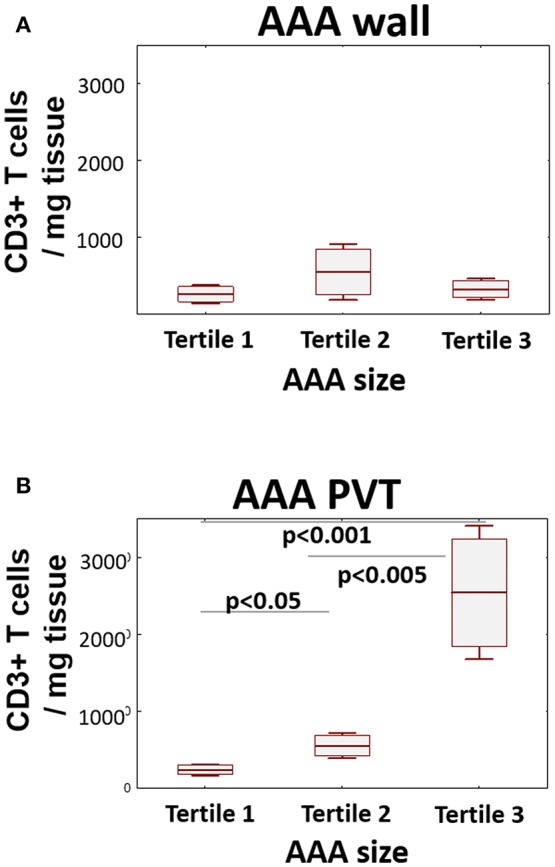
Relationship between T cell number and AAA size. AAA diameter was determined by preoperative CT. Graphs display relationship between AAA size (tertile 1 ≤ 53 mm; tertile 2 ≤ 60 mm; tertile 3 > 60 mm) and CD3+ cell infiltration in wall (A) and PVT (B) (mean/SEM/25–75 CI); (n = 20/10/9 for tertiles); statistical comparisons were performed by ANOVA with Neuman-Keuls post-hoc analysis.